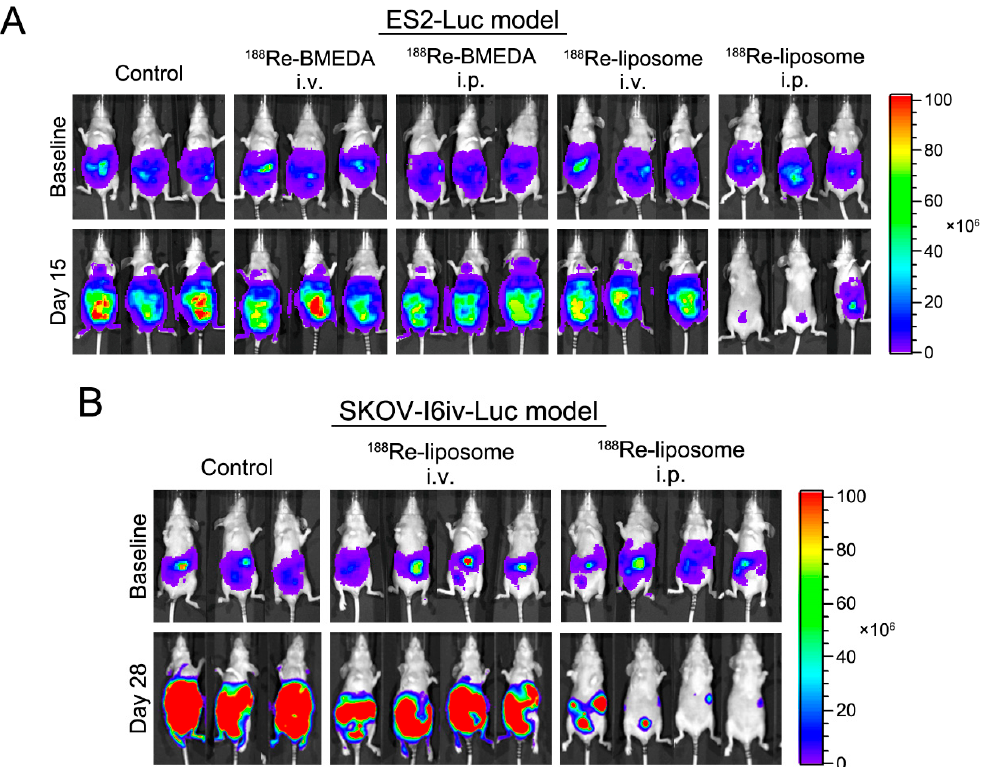
Figure 5. Intraperitoneal delivery of 188 Re-liposome offers significant tumor killing effects. Tumors originating from ES2-luc ( A ) and SKOV-I6-luc ( B ) cells were detected at Day 15 and 28 in the abdominal region of xenograft mice models. The In Vivo Bioluminescence Imaging System (IVIS) was applied to measure the intensity of tumor cells. Representative data are shown from triplicate ( A , B ) or quadruplicate ( B ) experiments.